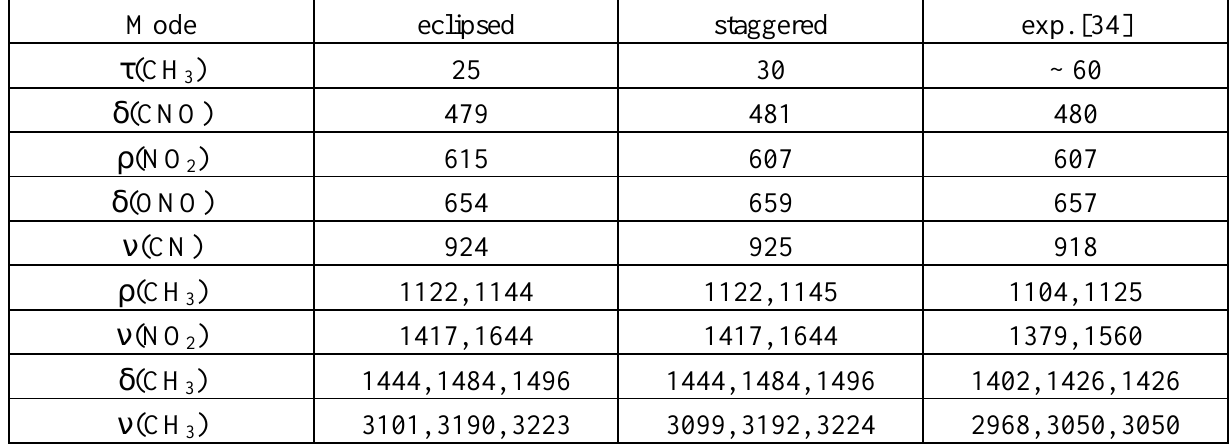
Table 3. Vibrational (cm -1 ) calculated at the optimum geometries reported in table